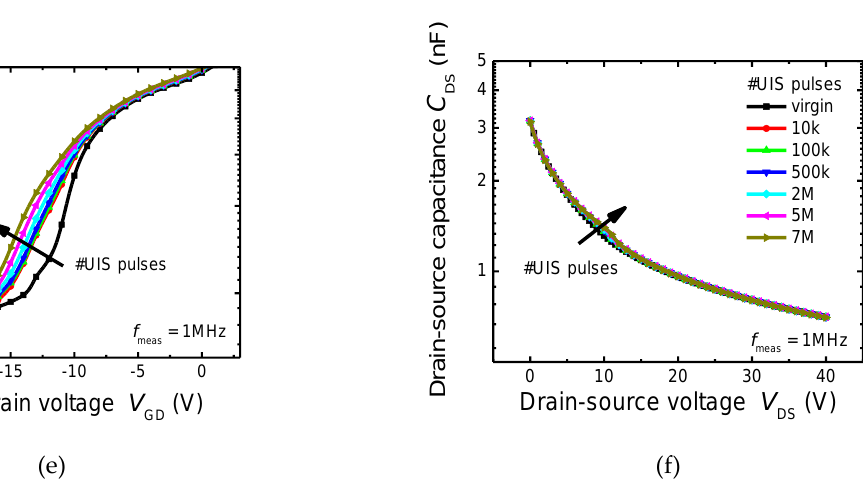
Figure 3. Measured the impact of repetitive UIS on the stability of electrical characteristics. ( a ) Output characteristics and on-resistance (inset graph), various colours of output characteristics stand for different numbers of UIS pulses, ( b ) transfer characteristics, ( c ) drain leakage current and breakdown, ( d ) gate leakage current, ( e ) gate – drain capacitance, ( f ) drain – source capacitance.